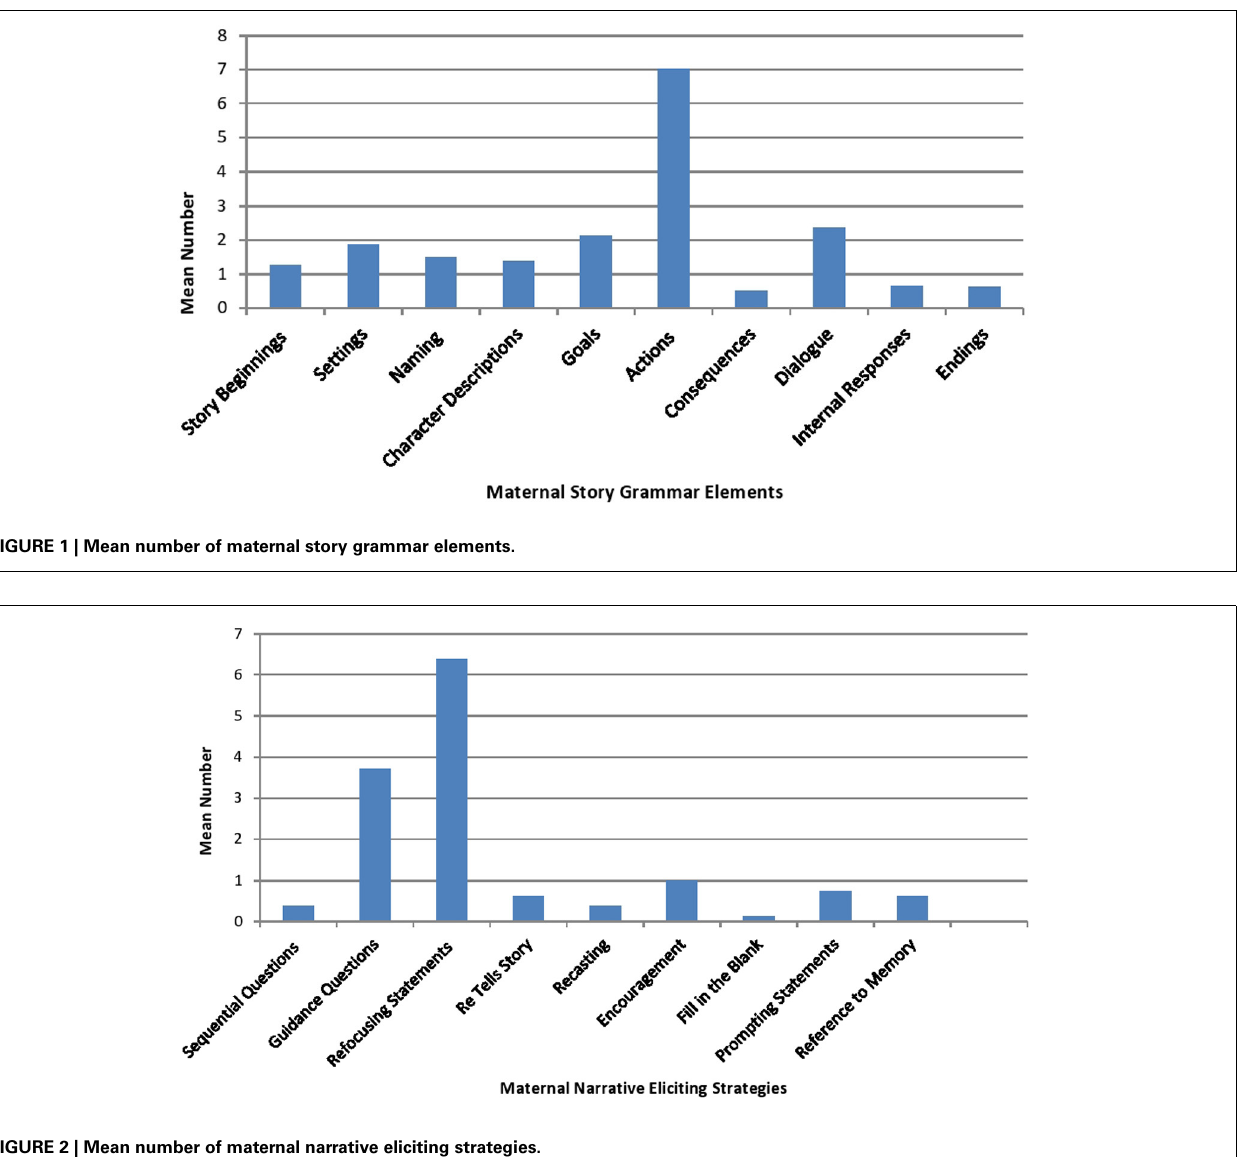
FIGURE 2 | Mean number of maternal narrative eliciting